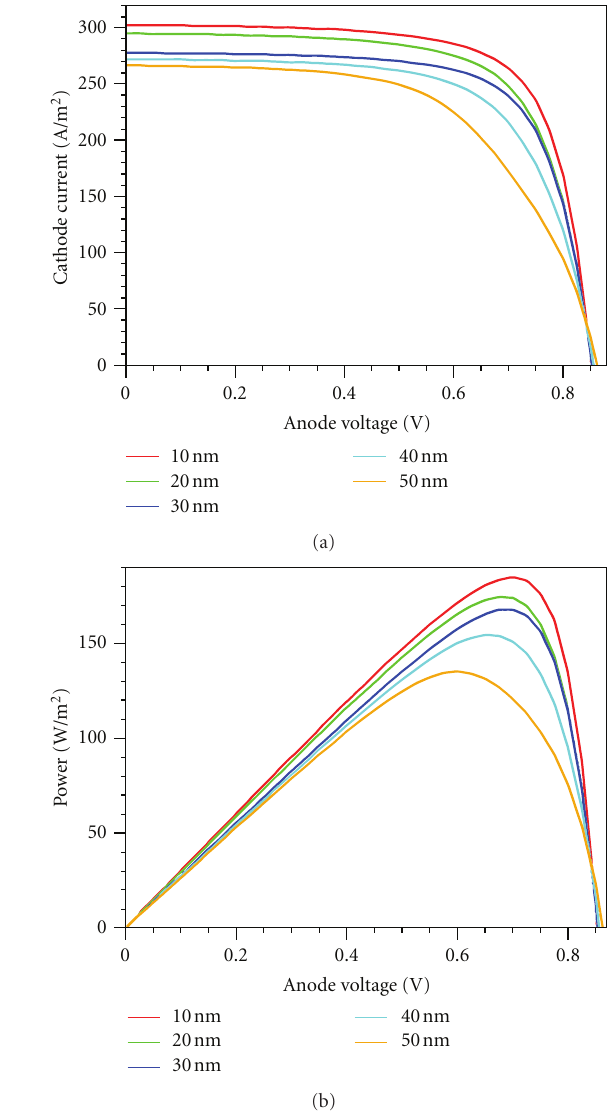
Figure 4: Recombination rate and electric field distribution of The a-SiGe:H solar cell device for di ff erent acceptor concentrations in p-layer.